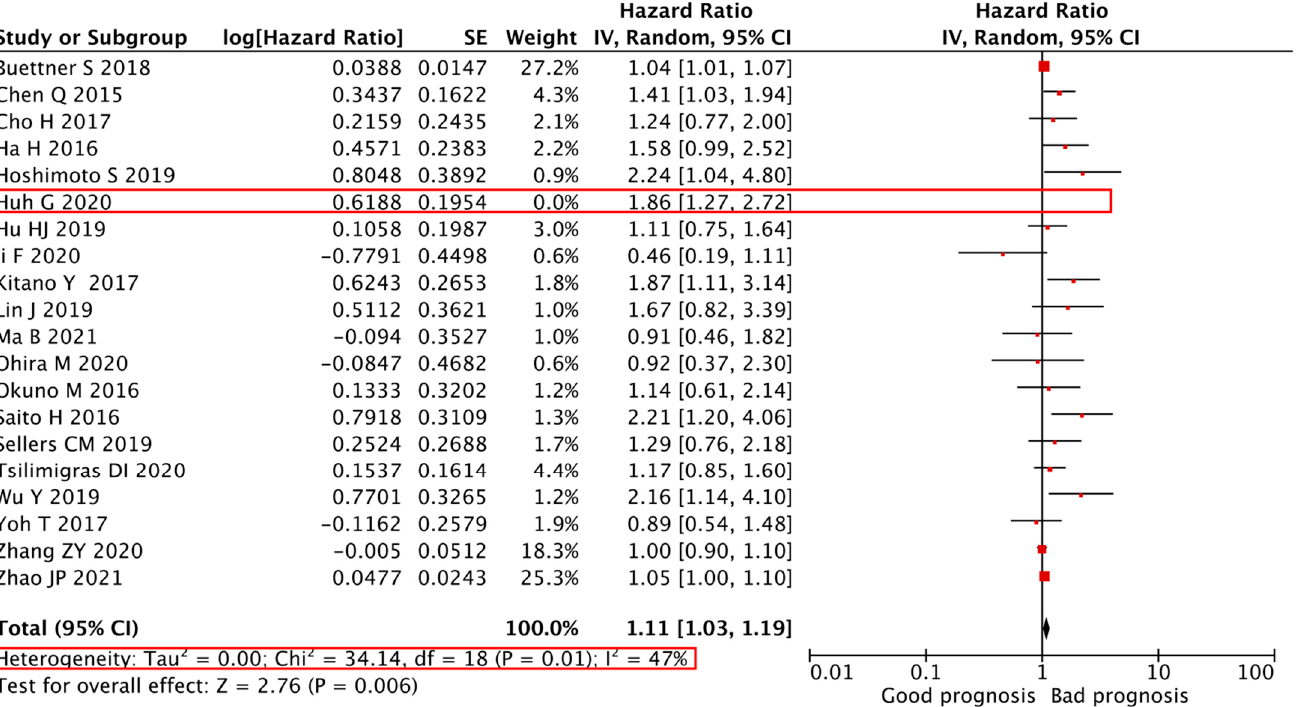
Figure 5. Sensitivity analyses of the association between the PLR and OS in CCA patients. Sensi- tivity analyses of the association between the PLR and OS of 20 studies. A random-effects model was used. OS, overall survival; PLR, platelet-to-lymphocyte ratio.